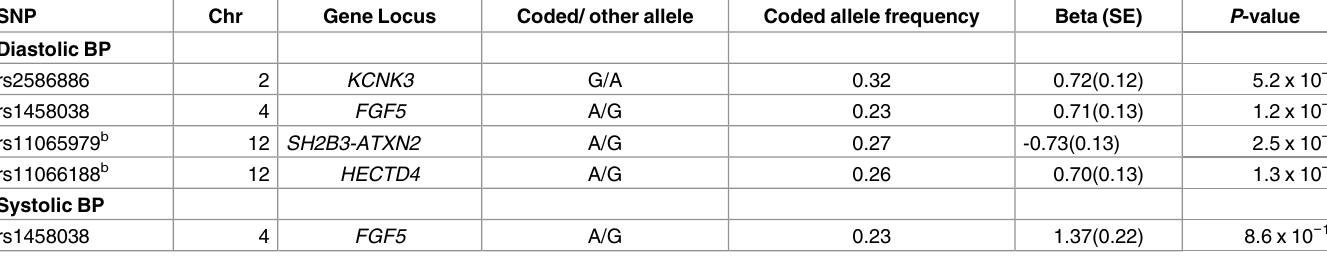
known BP loci rather than in Metabochip loci linked with other cardiometabolic traits. The